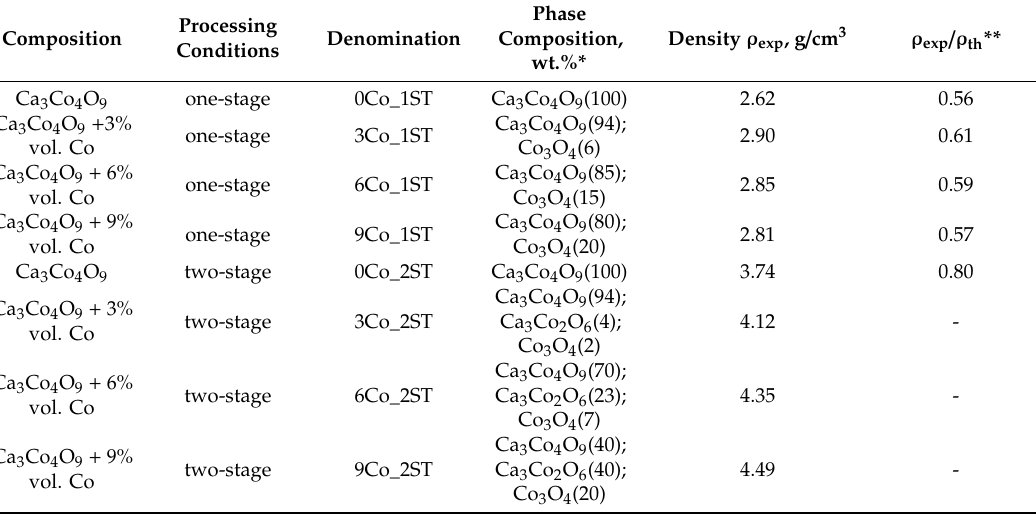
Table 1. Denominations, phase composition and density of the prepared ceramic